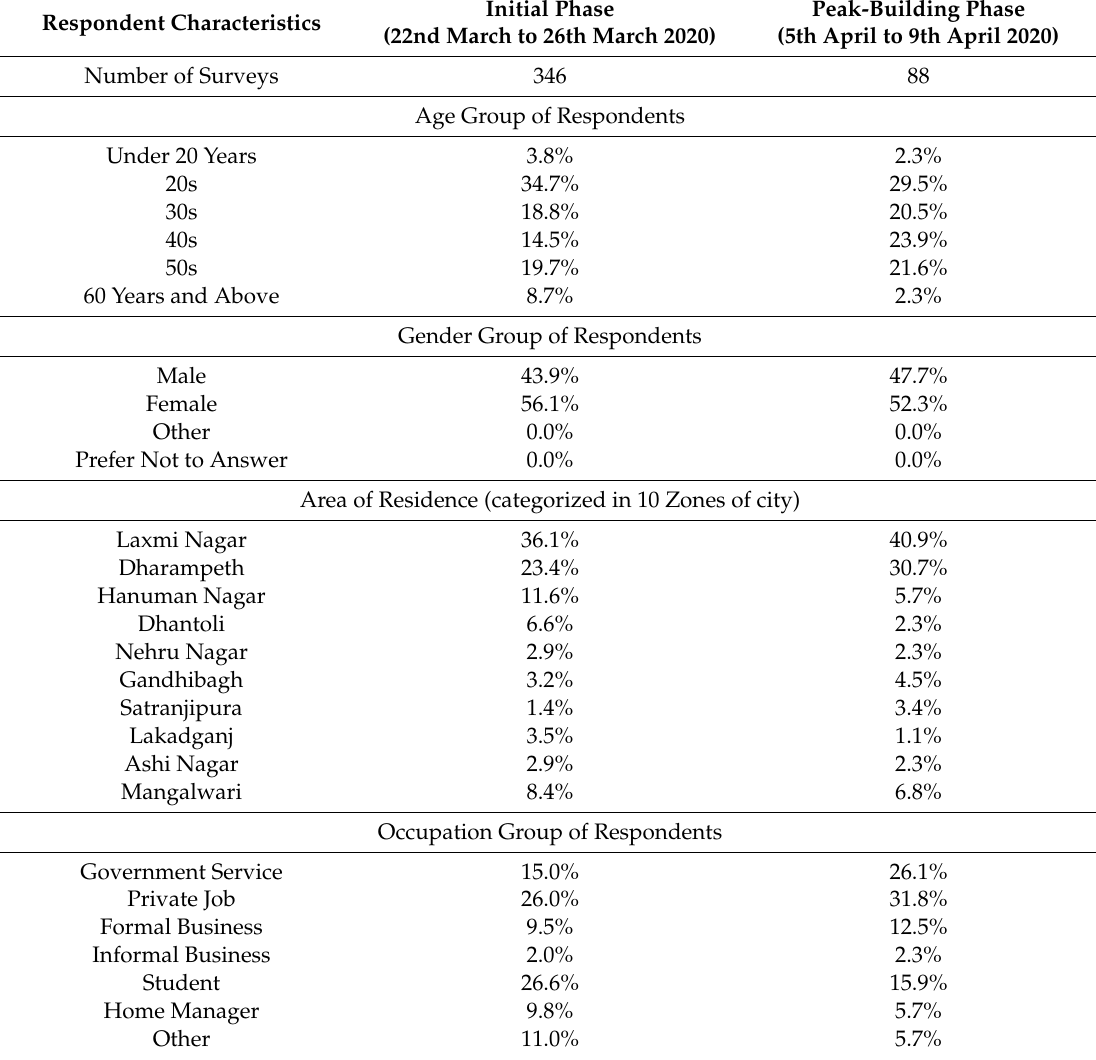
Table 3. Characteristics of survey